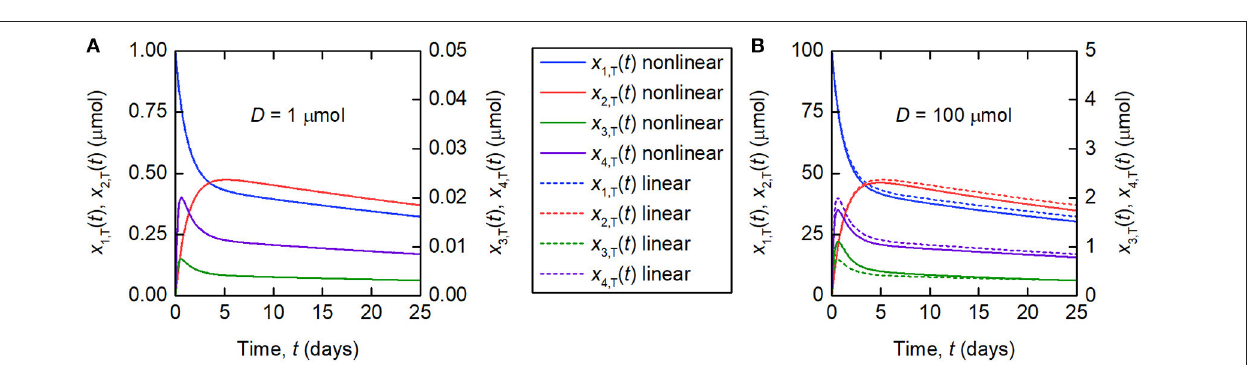
FIGURE 3 | Simulations of the quantities of tracer in each compartment after administration at t = 0 days, for a tracer dose of (A) 1 µ mol and (B) 100 µ mol. The nonlinear model (Equations 3–4) is represented by solid lines and the linearized model (Equations 6) by dashed lines. The linearized model is valid for the smaller dose but not for the larger dose. Note the different scales for x 1,T ( t ) and x 2,T ( t ), and x 3,T ( t ) and x 4,T ( t ), respectively.